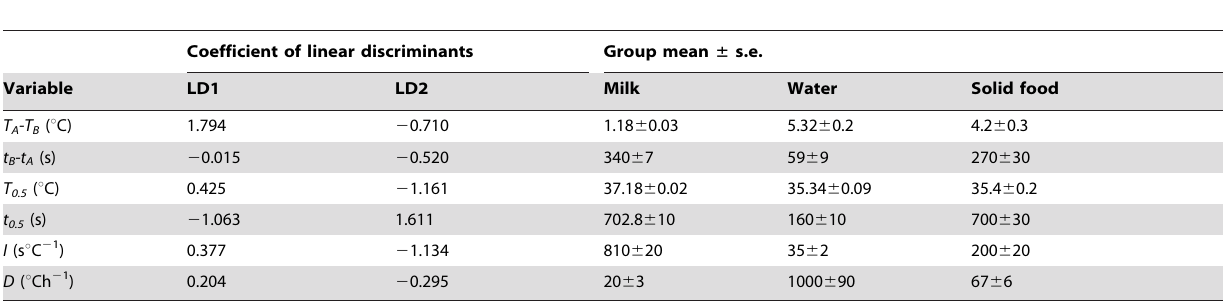
Table 5. Summary of the linear discriminant analysis on 6 stomach temperature variables for PDER events (n=1268) resulting from ingestion in nursed harbour seal